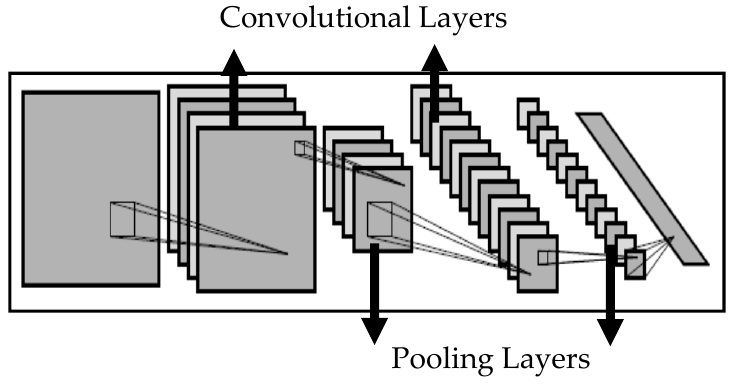
Figure 2. Schematic illustration of CNN [26].